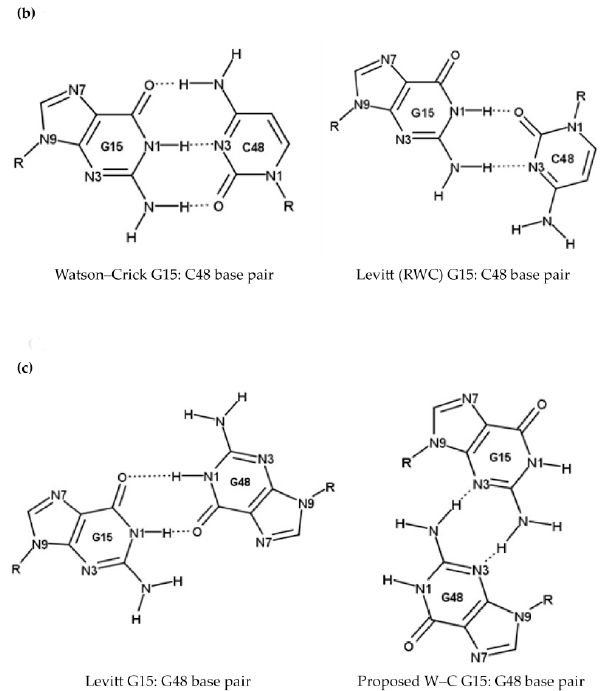
Figure 3. tRNA core structure and Levitt base pair model. ( a ) A three-dimensional model of the tRNA Phe tertiary structure, adapted from PDB File 1EHZ [46]. Nucleoside 15 in the variable loop forms a non-canonical base pair known as the ‘Levitt pair’ with the nucleoside 48 in the loop of the D stem and loop. The Levitt base pairing between nucleosides G 15 and C 48 is shown along with the U 8 :A 14 stacked bases below the G